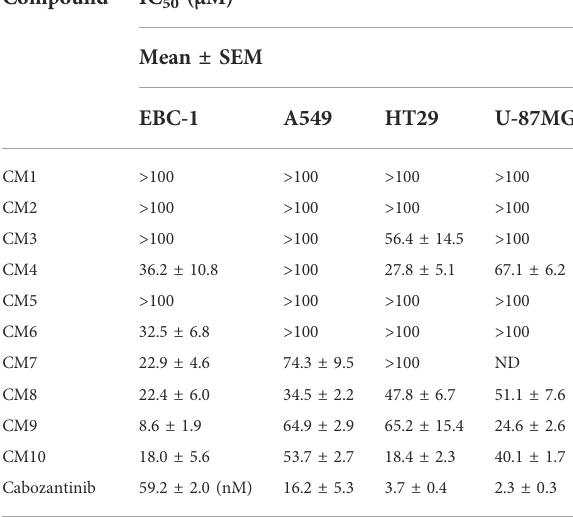
TABLE 2 Antiproliferative activity of synthetic quinazoline derivatives bearing various phenoxy-methylene-1,2,3-triazole pendants assessed by the MTT